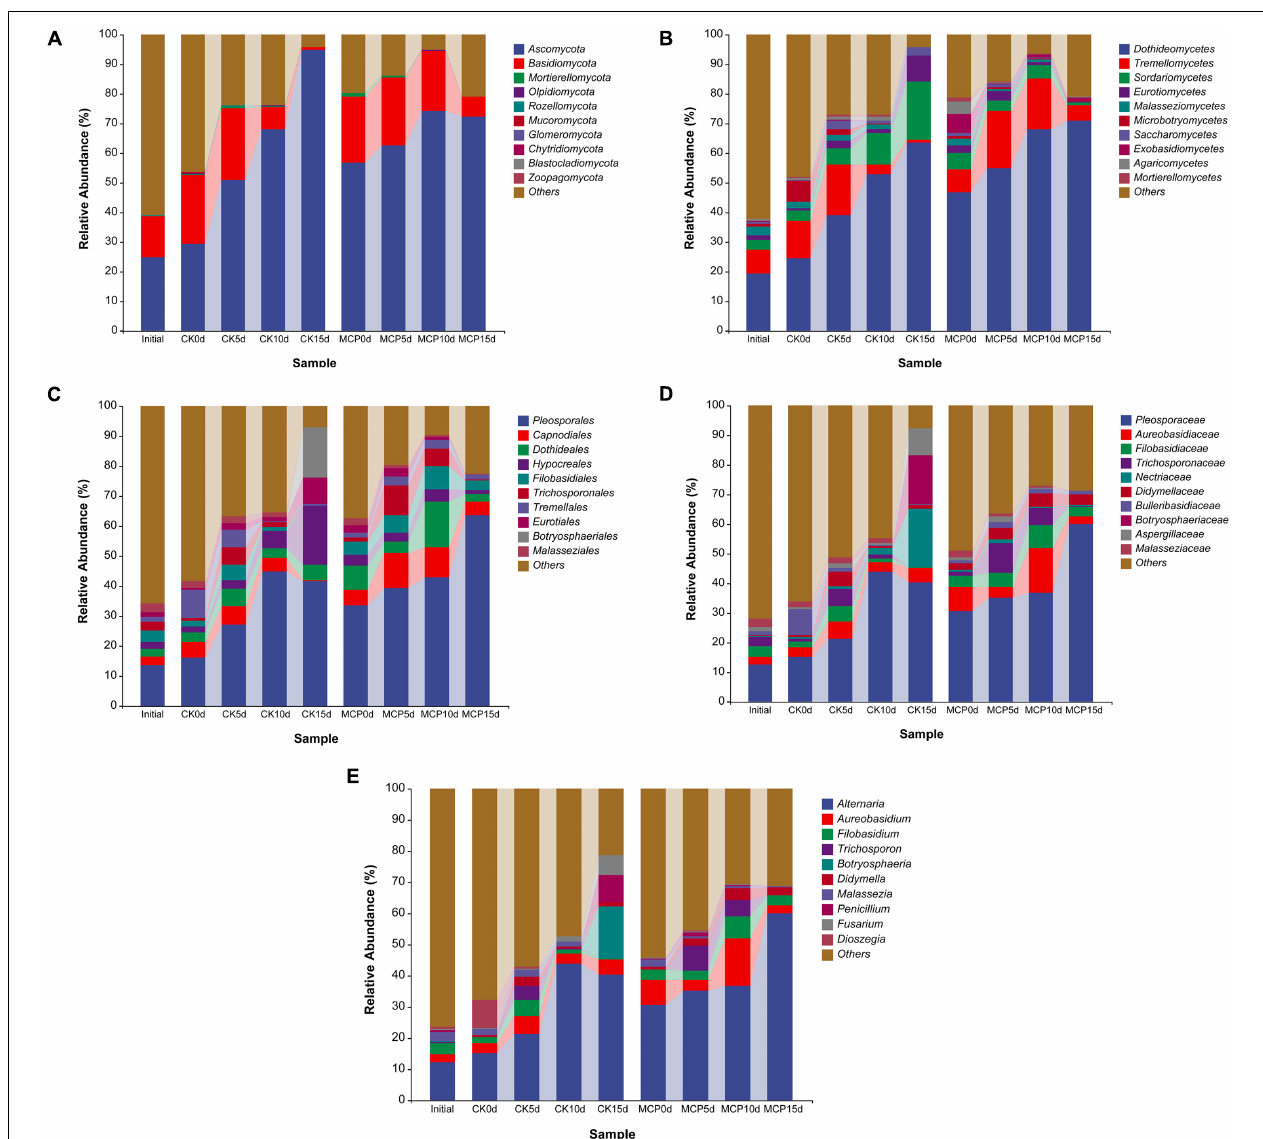
FIGURE 2 | Taxonomic composition of fungi at phylum (A) , class (B) , order (C) , family (D) , and genus (E) levels. Pear ( Pyrus communis L. cv. “Doyenne du Comice”) fruits were treated with or without 1.0 µ l L − 1 of 1-MCP during storage. Fruits were stored at 25 ± 0.5 ◦ C and relative humidity of 90 ± 5% for 0, 5, 10, and 15 days. The treatments were marked as CK0d, CK5d, CK10d, and CK15d, representing fruit stored for 0, 5, 10, and 15 days in the control group, while MCP0d, MCP5d, MCP10d, and MCP15d represent fruits stored for 0, 5, 10, and 15 days in the 1-MCP-treated group,